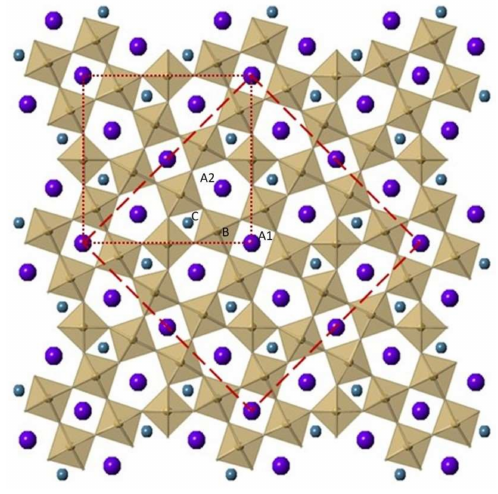
Figure 5. Tetragonal tungsten bronze (TTB) structure with tetragonal and orthorhombic unit cells indicated by dotted and dashed